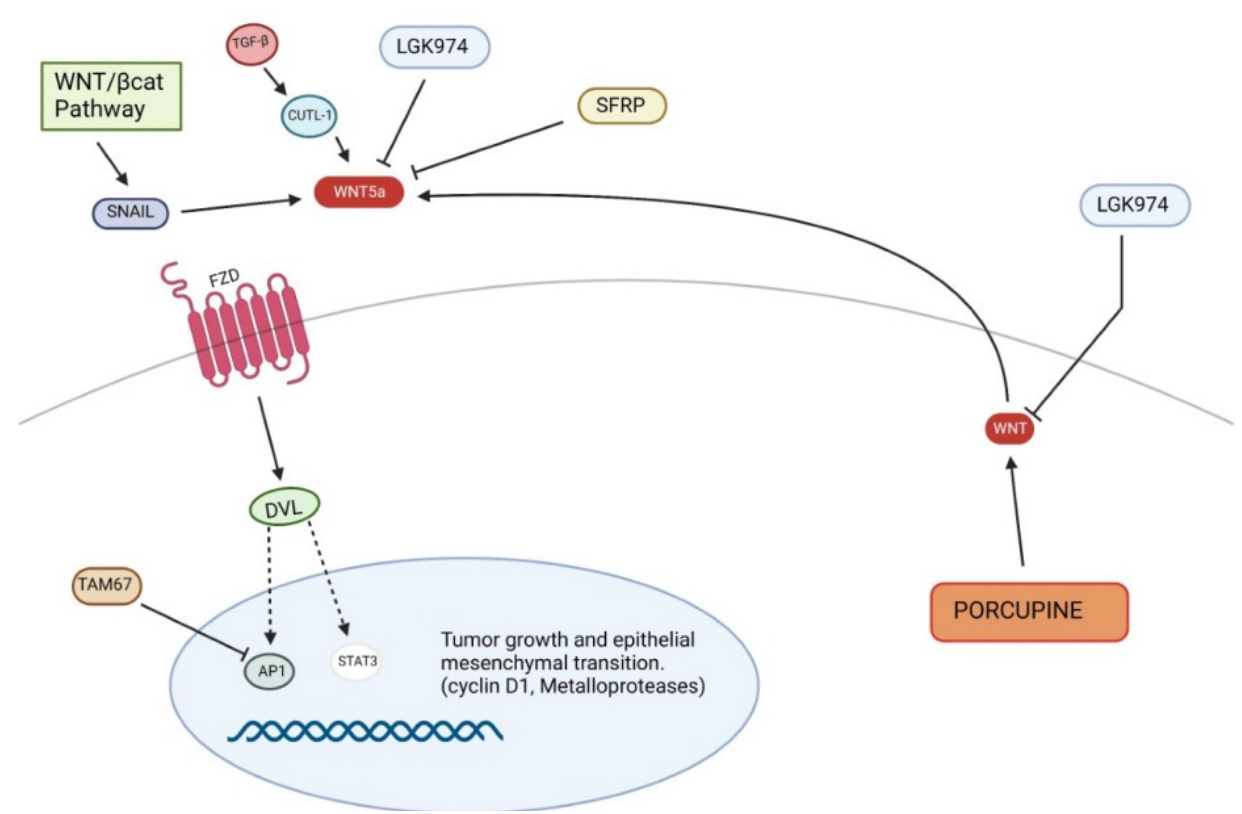
Figure 4. Non-canonical Wnt signaling pathway in pathogenesis of squamous cell carcinoma. STAT3, Signal transducer and activator of transcription 3.